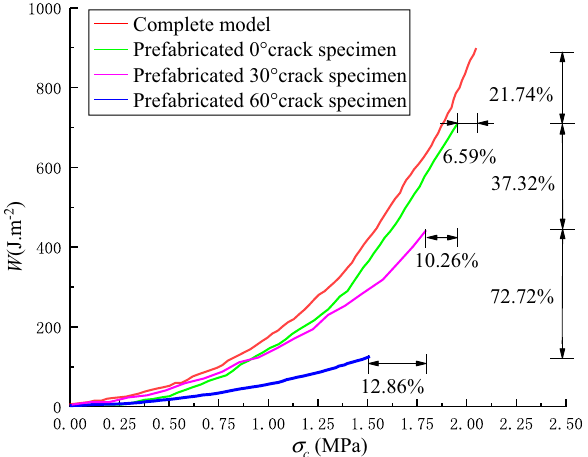
Figure 5. Relationship between peak energy density and tensile